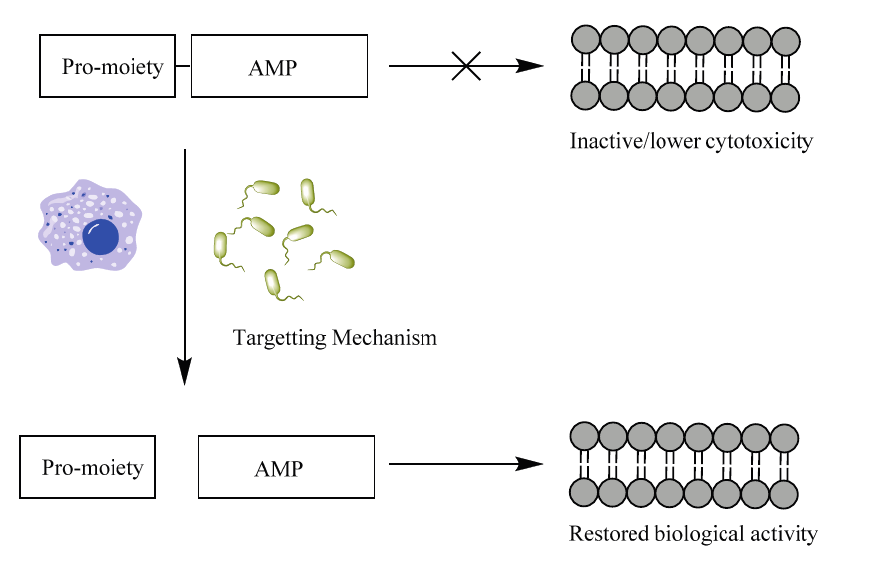
Figure 1. Overview of AMP prodrug model. The pro-moiety prevents the active AMP from interacting with cell membranes, both bacterial and mammalian, reducing both activity and cytotoxicity. The targeting mechanism, e.g., bacterial or host enzymes, releases the active AMP, restoring activity and limiting cytotoxic effects distal from the site of